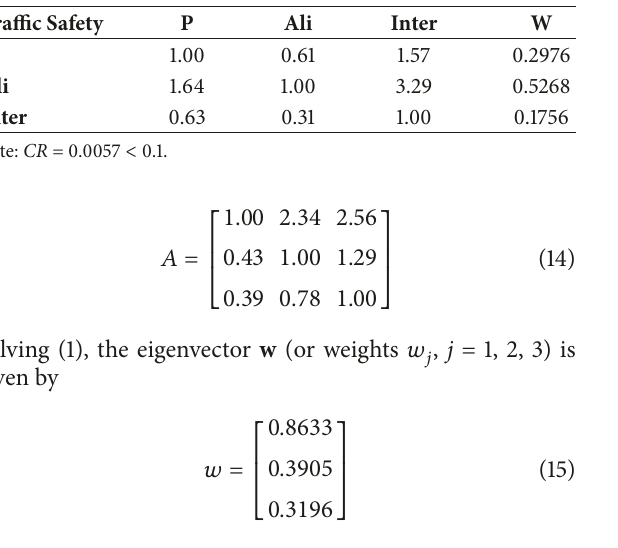
Table 5: Cluster comparison for “traffic safety”. Table 6: Comparison for superelevation